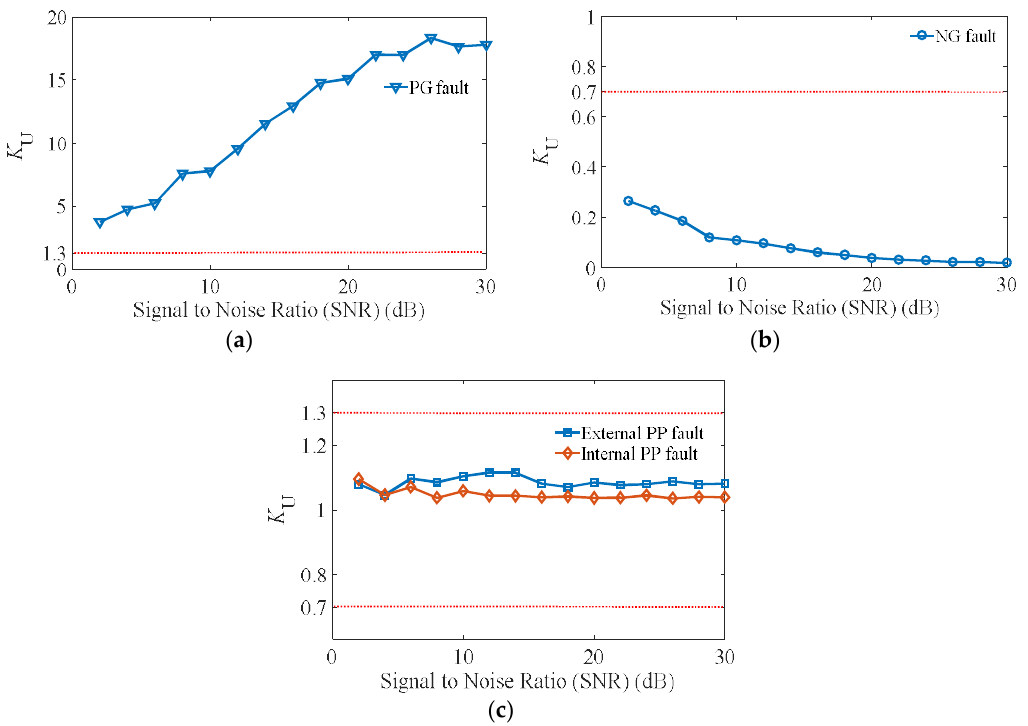
Figure 14. Simulation results for the influence of signal noise: ( a ) Positive-pole-to-ground (PG) fault; ( b ) Negative-pole-to-ground (NG) fault; ( c ) Pole-to-pole (PP) fault. Energies 2018 , 11 , x FOR PEER REVIEW